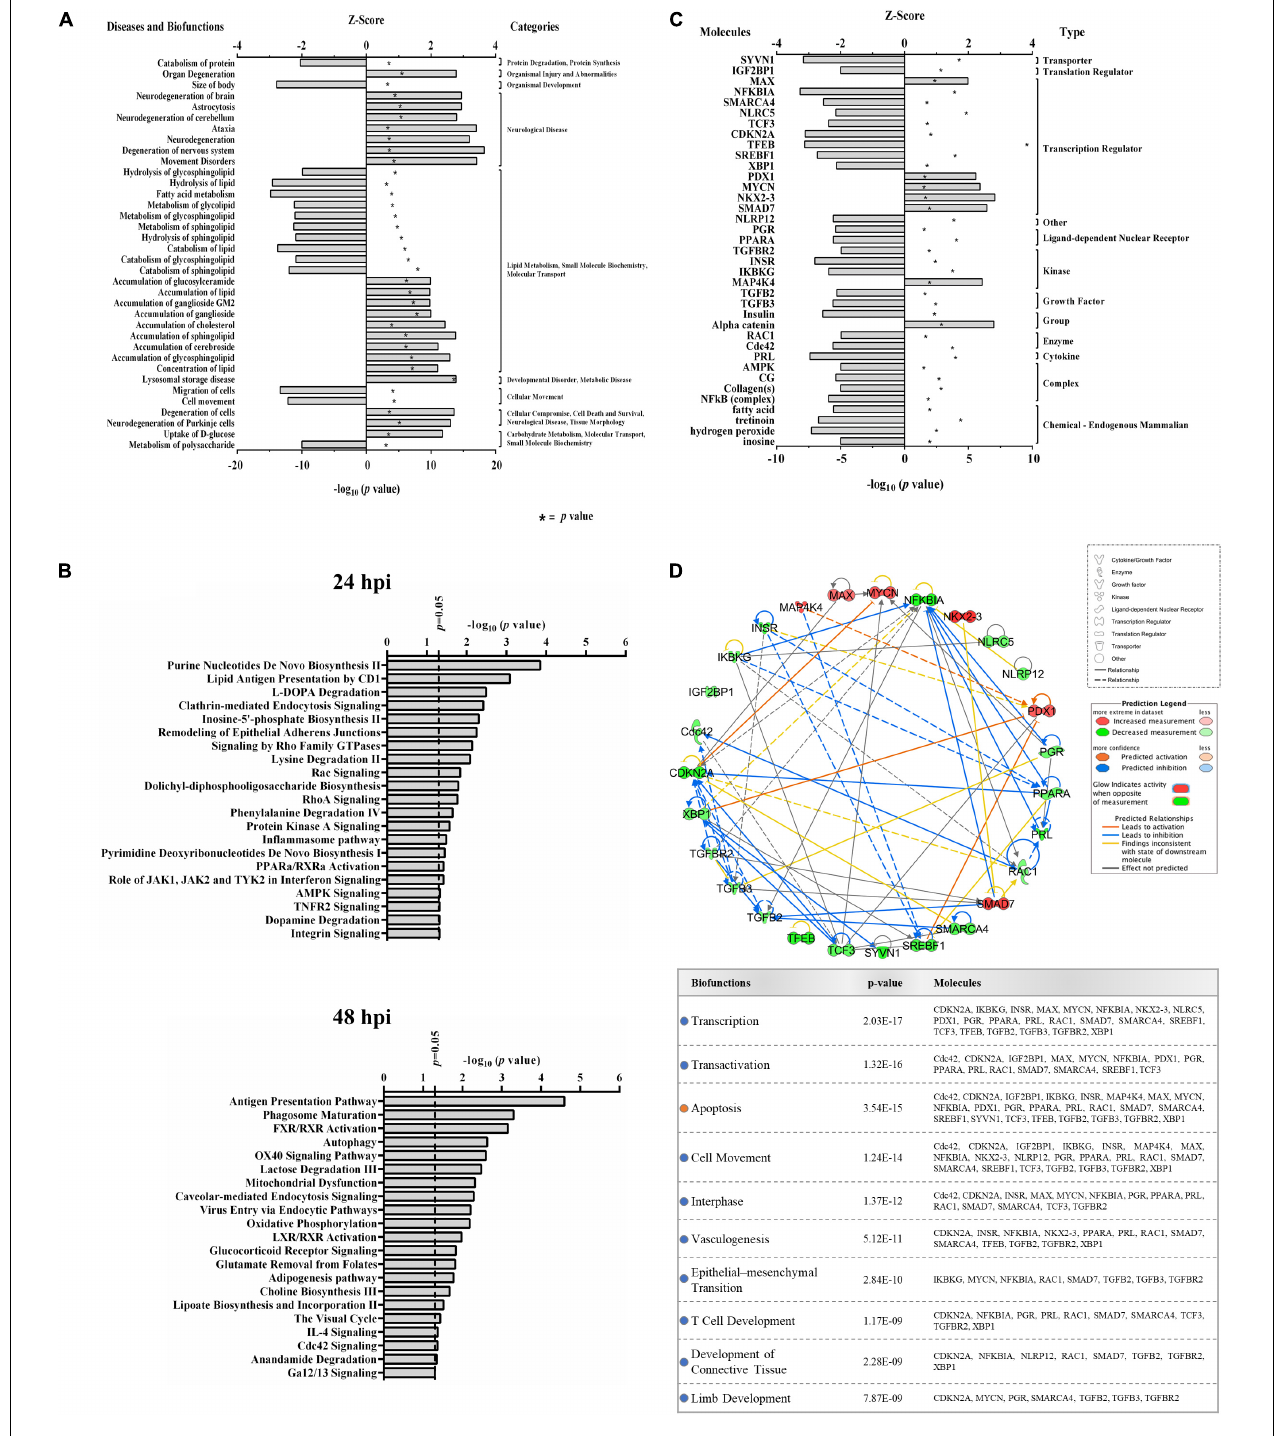
FIGURE 2 | Proteomic prediction of top affected bio-functions, canonical pathways, and upstream molecules in Vero cells after ZIKV infection. (A) Predicted activation or inhibition patterns of top affected bio-functions at 48hpi based on Z -scores (upper x –axis) and log 10 p –values (lower x –axis indicated by asterisk). Influenced bio-functions are grouped using major parental categories of functions (shown at right). (B) Prediction of top affected canonical pathways by ZIKV at 24 (upper panel) and 48 (lower panel) hpi. (C) Prediction of top affected upstream molecules and their possible activation or inhibition based on expression patterns of downstream proteins at 48 hpi. (D) Interaction network of top predicted upstream molecules (upper panel) and their related bio-functions (table in lower panel). Activation or inhibition patterns of connected bio-functions and interaction types of predicted molecules are measured according to Z -scores calculated from IPA software, which is based on the expression of differentially regulated downstream proteins at 48